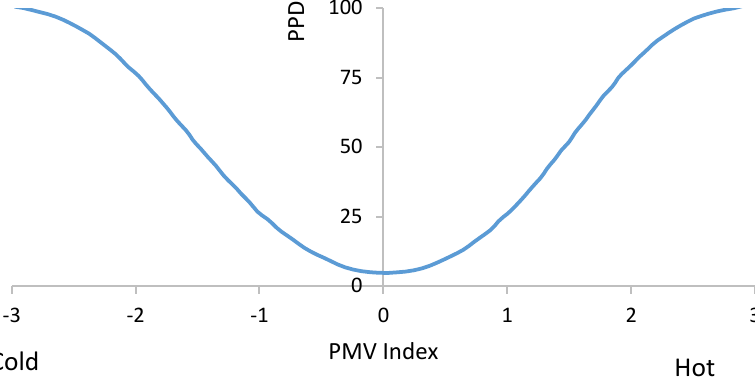
Figure 4. Predicted percentage dissatisfaction (PPD) as a function of predicted mean vote (PMV).